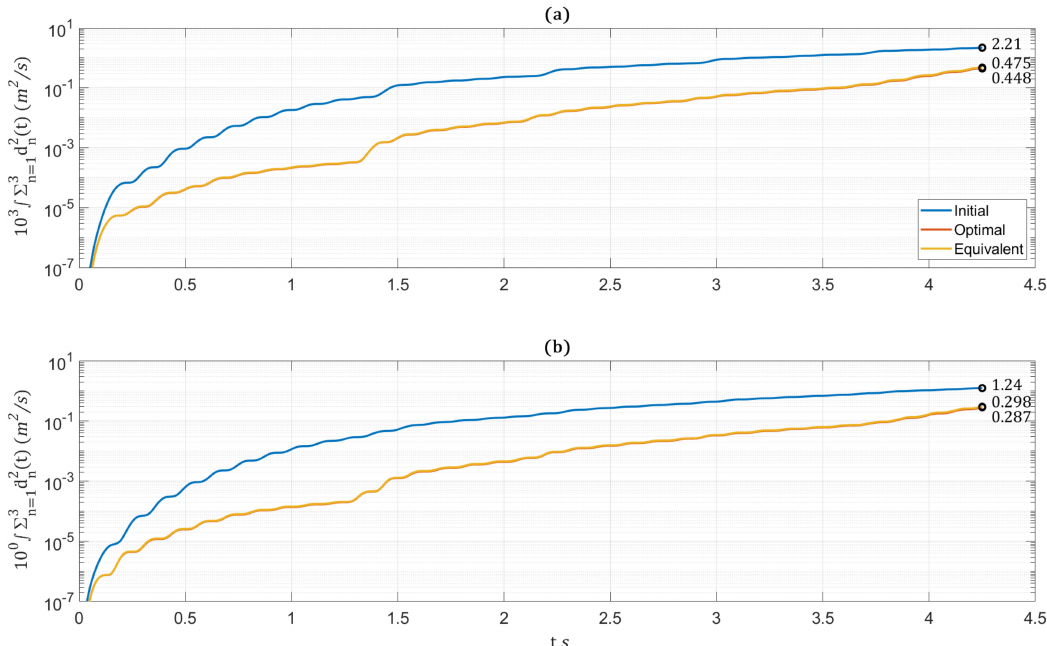
Figure 9. Trajectories of the three-story inelastic rigid frame system: ( a ) interstory drifts ( b ) interstory drift